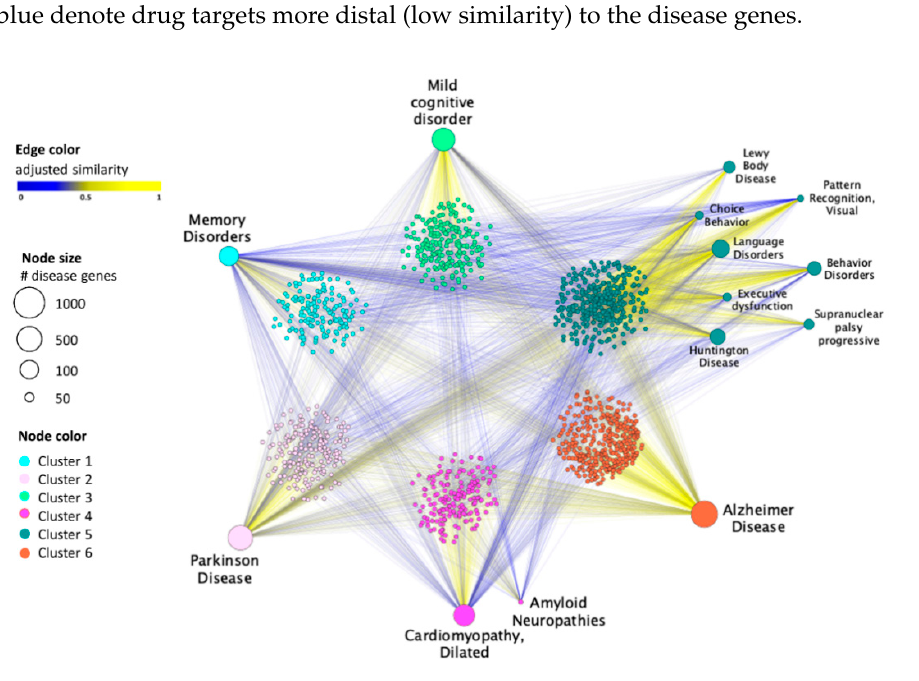
Figure 2. Drug–disease network. This graph shows the high-confidence predicted drug–disease associations connecting 14 diseases (bigger labelled circles) with the 1468 FDA-approved drugs (smaller circles). The node sizes are scaled with the number of genes associated to each analyzed disease. The edge color denotes the adjusted similarity between the drug targets and disease genes mapped on the human interactome, increasing from blue (less similar) to yellow (more similar). The node color refers to one of the six clusters identified by SAveRUNNER according to the label reported in the legend. For the clusters’ identification on the drug–disease network, SAveRUNNER exploits a cluster detection algorithm based on greedy optimization of the network modularity [35].